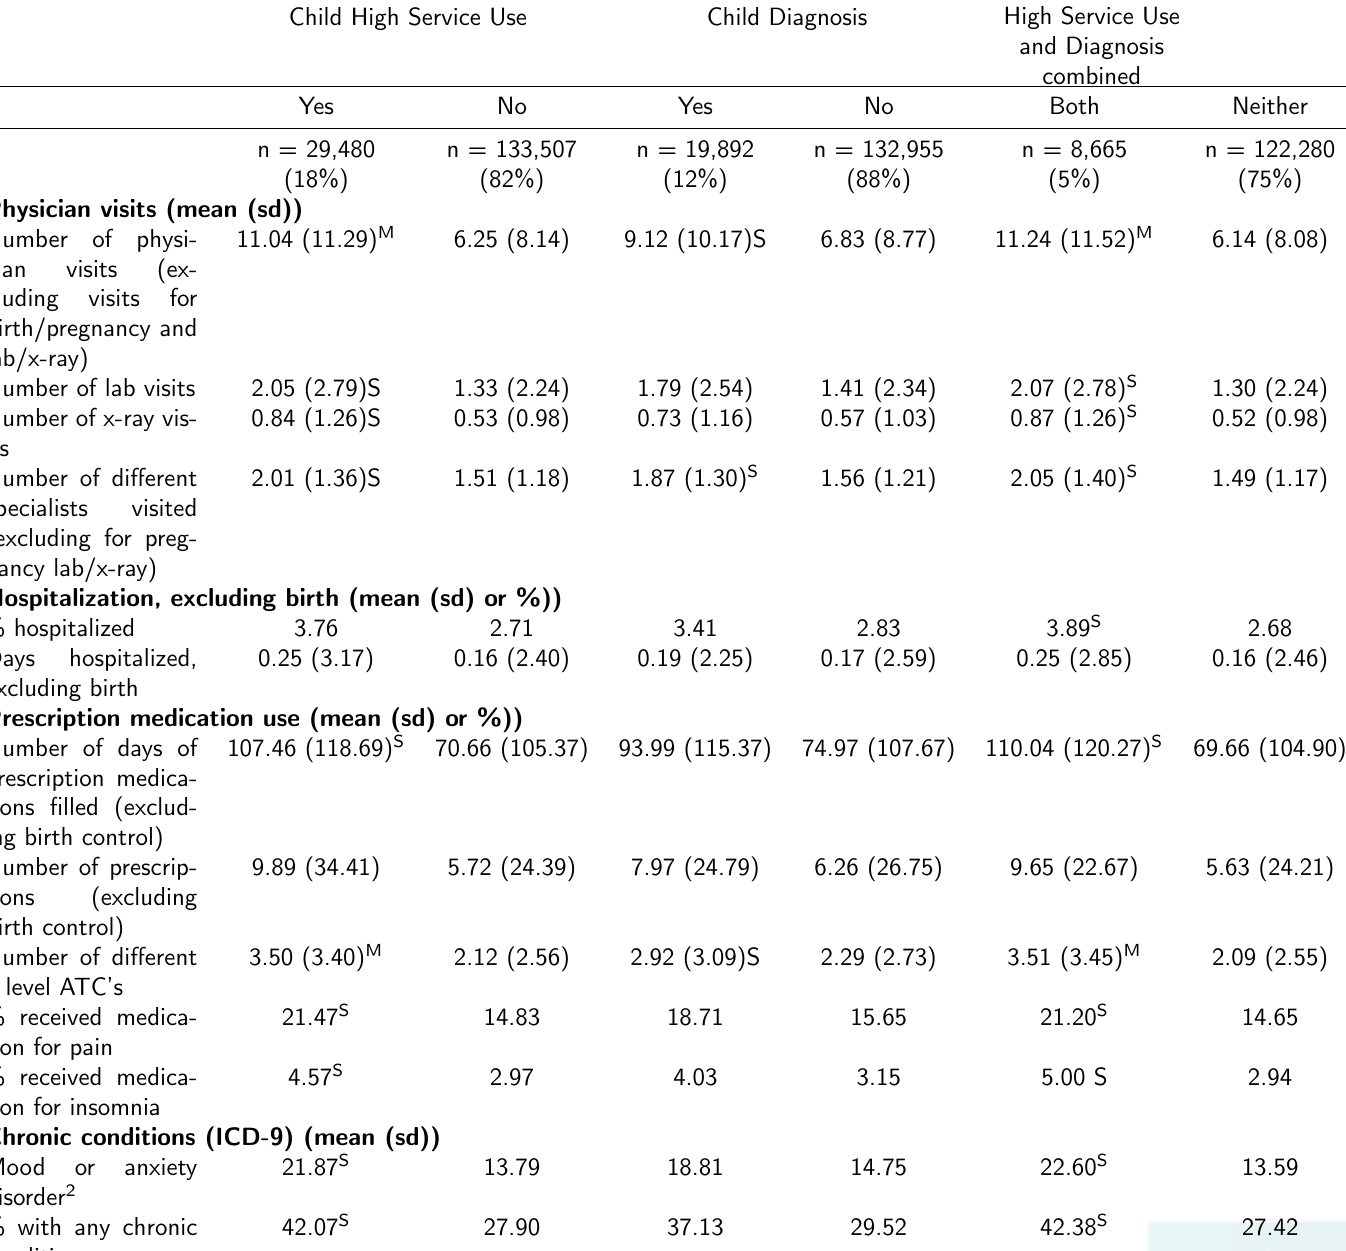
Table 3: Maternal health outcomes